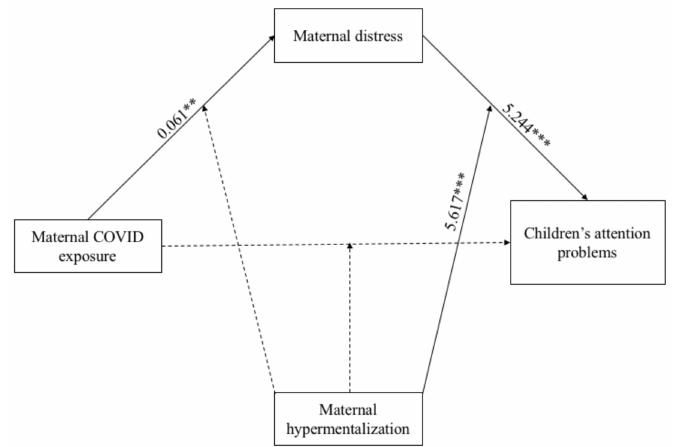
Figure 4. Results of the Moderation Mediated Model 2. Note: ** p < 0.01; *** p < 0.001. Only significant path coefficients are displayed; not significant paths were displayed by dotted lines. The covariates are not displayed here, but they were estimated in the